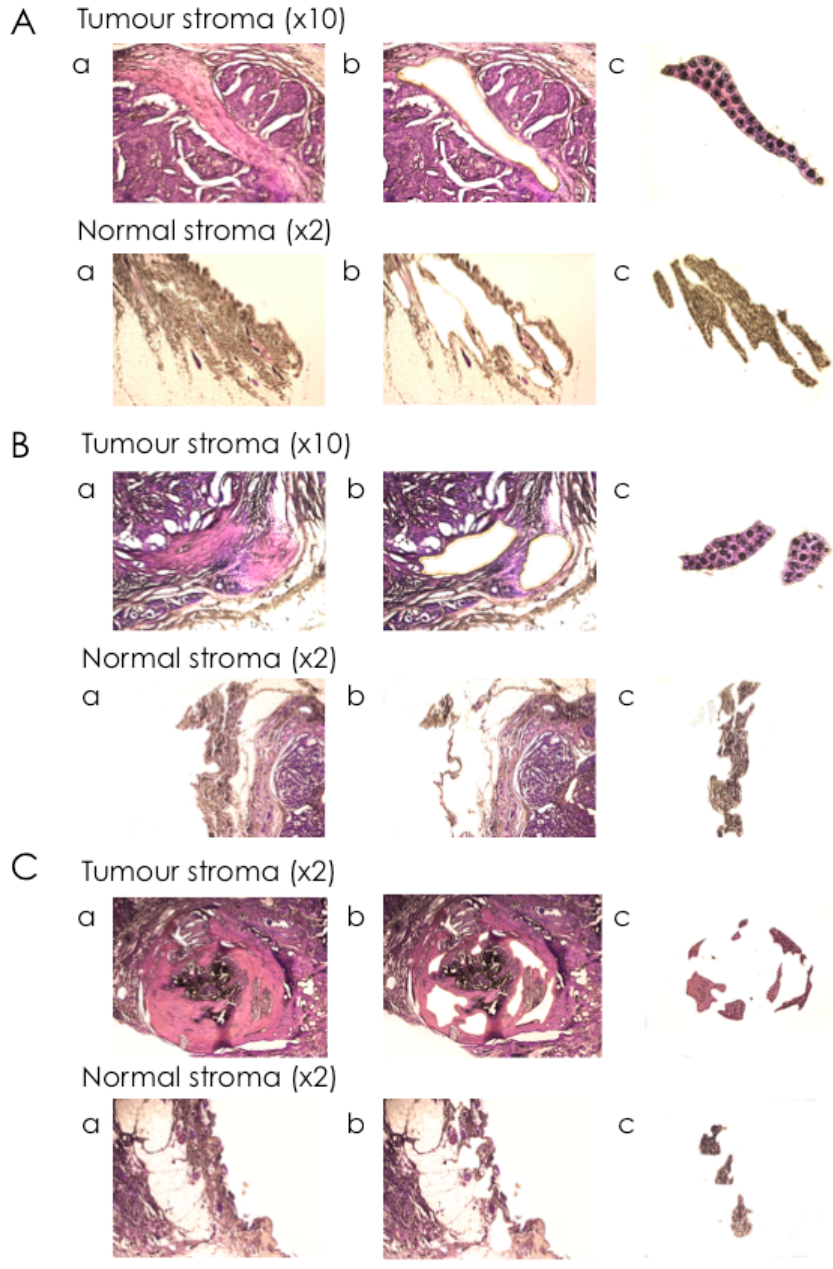
Figure 2. Selective isolation of cancer-associated stroma and normal stroma from canine simple mammary carcinomas by laser-capture microdissection. Representative images of tissue mounted on the slide were taken at ×2 and ×10 magnification, as indicated, ( a ) before dissection; ( b ) after dissection; and ( c ) of the CapSure ® Cap containing the excised tissue sections to validate the isolation of the selected cells. The dark spots visible in the CapSure ® Cap samples denote the area of the melted thermoplastic film of the cap by the infrared laser and thus of adhering tissue. Three representative cases were chosen. Cases: ( A ): Case #3; ( B ): Case #4; ( C ): Case #6.